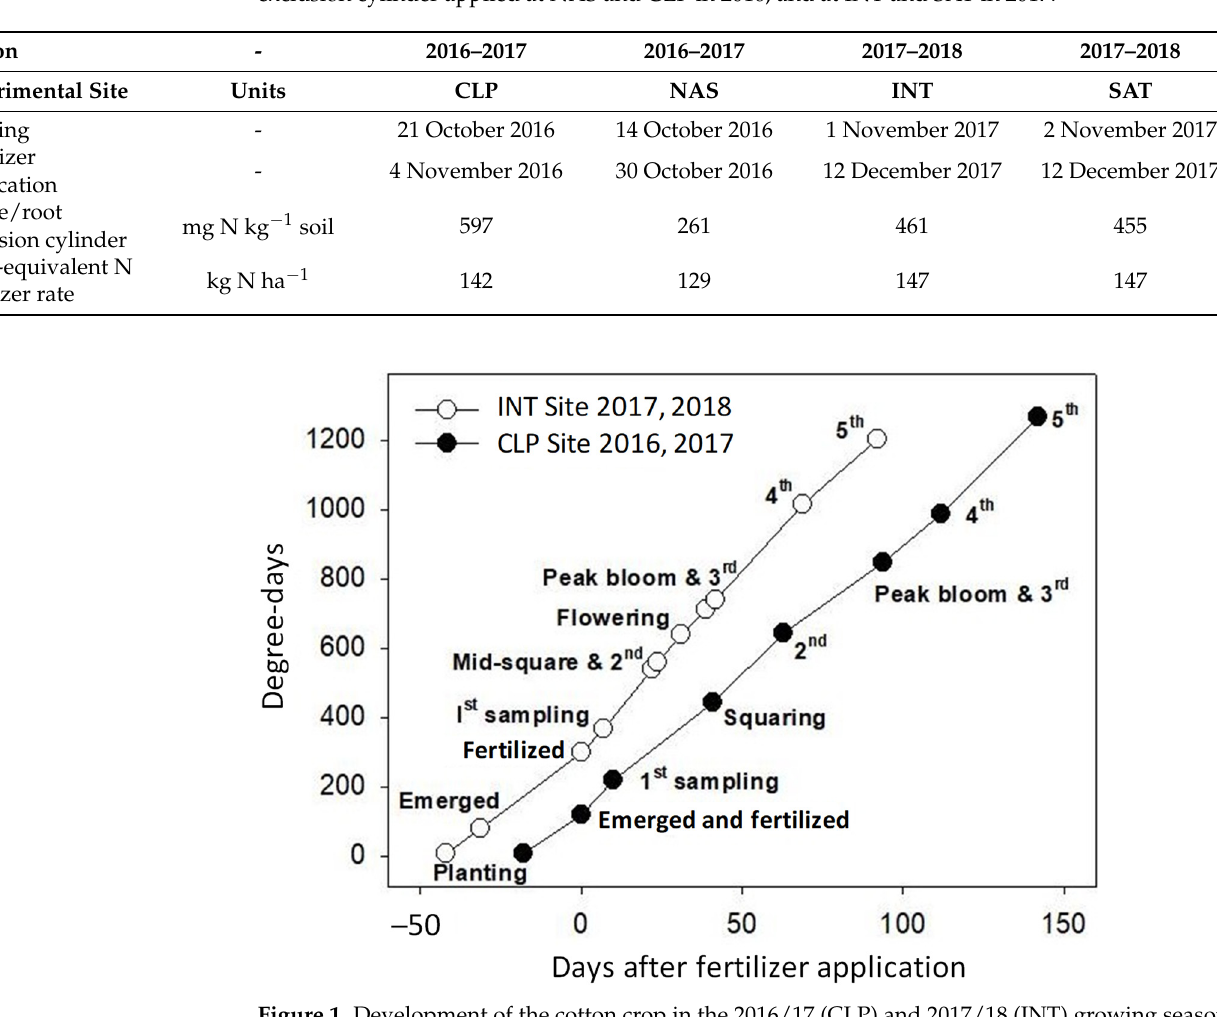
Table 2. Crop sowing date, date of nitrogen (N) fertilizer application, and N fertilizer rate per root exclusion cylinder applied at NAS and CLP in 2016, and at INT and SAT in 2017.